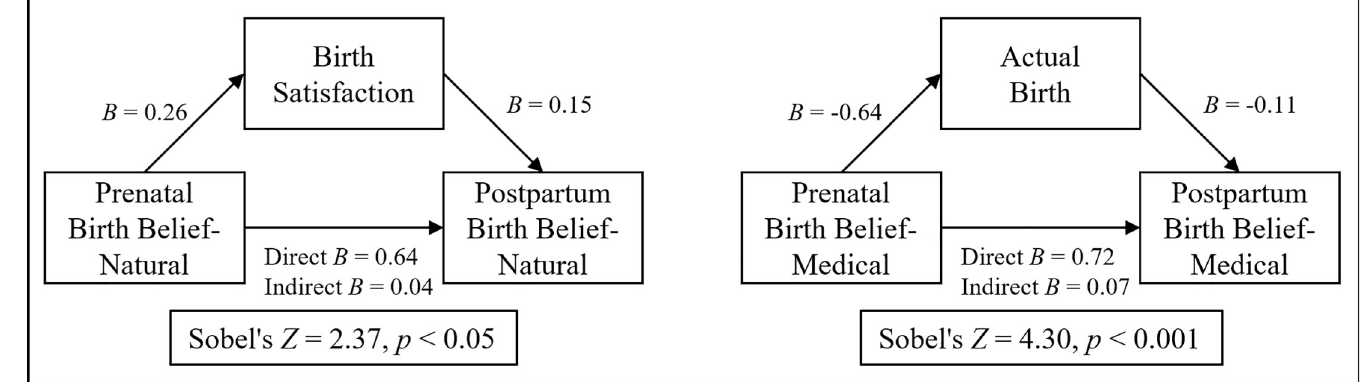
Fig 1. Mediation effects of Actual Birth and Birth